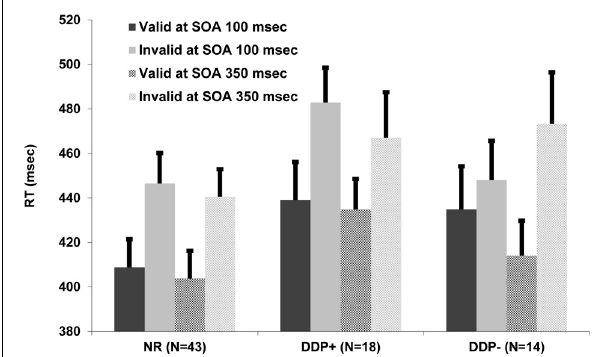
FIGURE 3 | Mean RT and standard error as a function of group (NR, DDP + , and DDP − ), target condition (valid vs. invalid cue), and cue-target SOA (100 and 350ms).